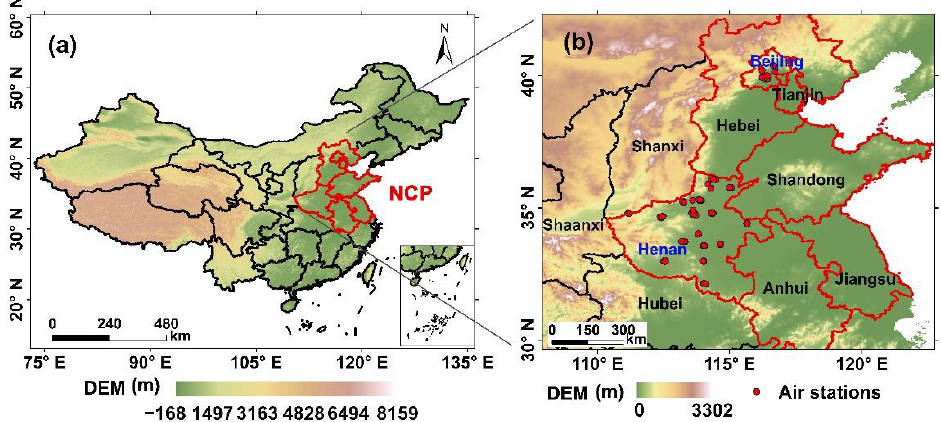
Figure 1. ( a ) Map of study area, and ( b ) locations of the air-quality monitoring sites in Beijing and